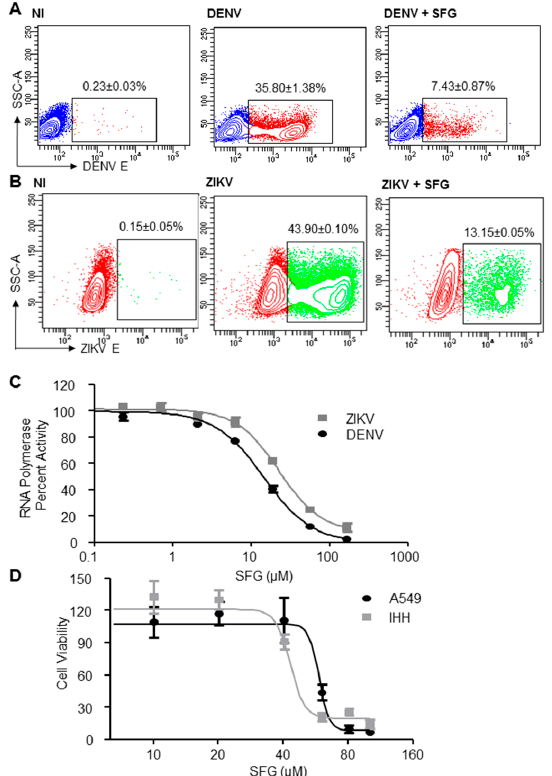
Figure 2. SFG is a direct acting anti-Flaviviral agent that inhibits the viral polymerase. ( A ) SFG inhibits DENV replication post infection. A549 cells were plated, then infected with DENV at a MOI of 0.5. After 5 h of infection, SFG was added at a concentration of 20 μ M. The cells were harvested for flow cytometry analysis 48 h later. ( n = 3); ( B ) SFG inhibits ZIKV replication post infection. A549 cells were plated, then infected with ZIKV (MOI 0.5). After 5 h of infection, SFG was added at a concentration of 20 μ M. The cells were harvested for flow cytometry analysis 48 h later. ( n = 2); ( C ) the polymerase activity of ZIKV and DENV is inhibited by SFG. Following the addition of 0.2–167 μ M SFG, the amount of radiolabeled GMP incorporated by the viral polymerases into newly synthesized RNA was measured via an in vitro RdRp assay. The IC50 for DENV is 14.5 µ M (95% Confidence Intervals: 12.3–17.1), and for ZIKV is 22.6 µ M (95% Confidence Intervals: 18.9–27.1). ( n = 3); ( D ) the toxicity of SFG is demonstrated in IHH and A549 cells. Cells were plated, then treated with a range of SFG doses: 10, 20, 40, 60, 80 and 100 µ M. 24 h later, cell viability was measured via MTT assay. ( n =